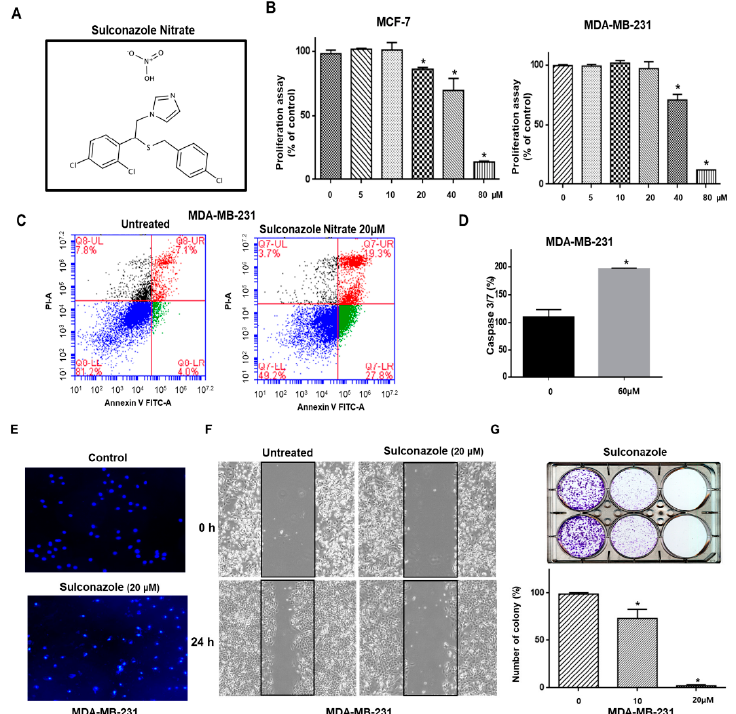
Figure 1. Sulconazole inhibits cell proliferation in breast cancer. ( A ) The molecular structure of sulconazole is shown. ( B ) Breast cancer cells were incubated in a 96-well plate with the indicated concentration of sulconazole. Cell proliferation was measured by an MTS assay. ( C ) Sulconazole induced apoptosis in cancer cells at the indicated concentration. Apoptotic cells were determined using Annexin V / PI staining. ( D ) The caspase3 / 7 activity of cancer cells was determined using a Caspase-Glo 3 / 7 assay kit (Promega). The data are presented as the mean ± SD; n = 3 independent experiments; * p < 0.05 vs. the control (0.3% DMSO). ( E ) Apoptotic cells were analyzed by fluorescence nuclear staining using Hoechst 33,258 dye (magnification, 40 × ). ( F ) The e ff ect of sulconazole on the migration of cancer cells was evaluated using a scratch assay. The scratch assay was performed with cancer cells treated with sulconazole. ( G ) The e ff ect of sulconazole on colony formation is shown. 1000 cancer cells were incubated in 6-well plates with sulconazole (0.1% DMSO) and 0.1% DMSO. Representative images were recorded. The data are presented as the mean ± SD; n = 3 independent experiments; * p < 0.05 vs. the